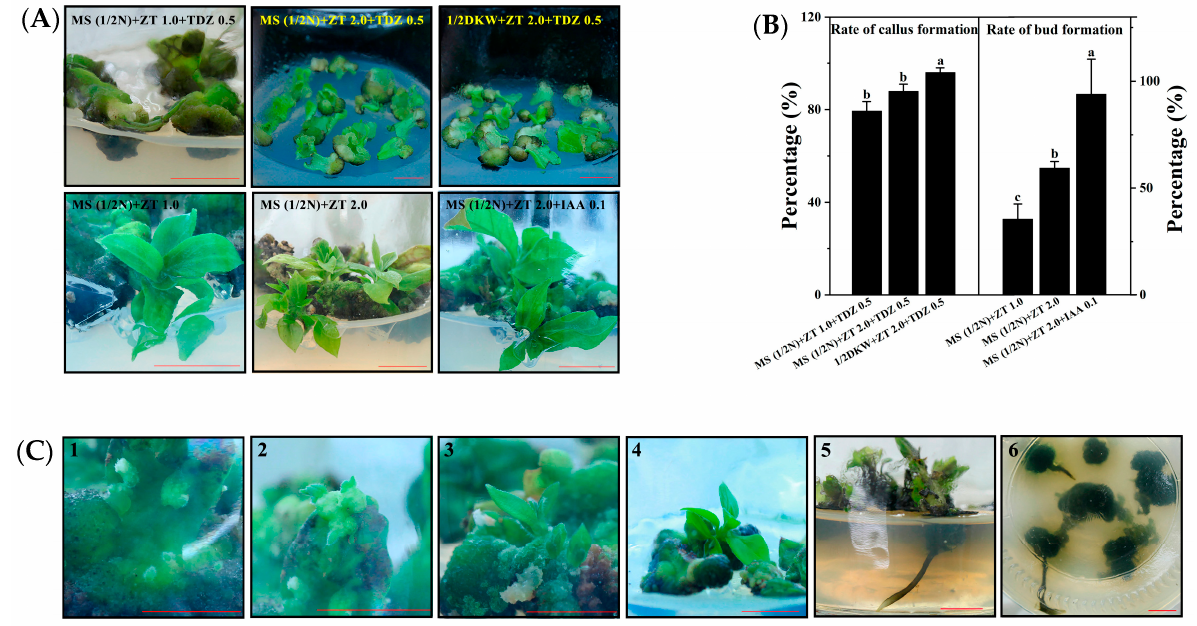
Figure 2. In vitro propagation of ‘Gongcheng Shuishi’ persimmon leaves. ( A ) Callus induction (20 days) and adventitious bud regeneration (1–2 months) of ‘Gongcheng Shuishi’ in different media. ( B ) The rate of callus formation and bud formation of ‘Gongcheng Shuishi’ in different media. ( C )